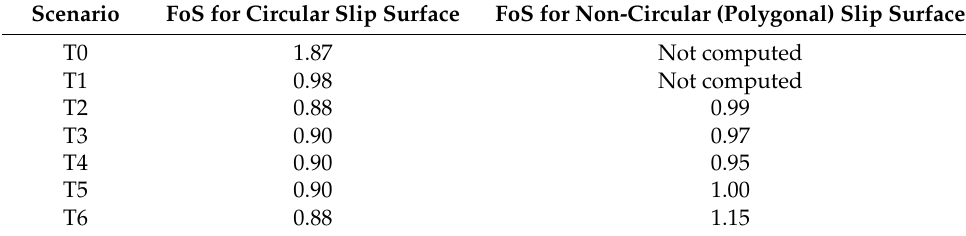
Table 4. Comparison of FoS if a circular or a polygonal slip surface is taken into account. The polygonal slip surface corresponds to the remaining topography of 1984, while the circular one is calculated with the Bishop